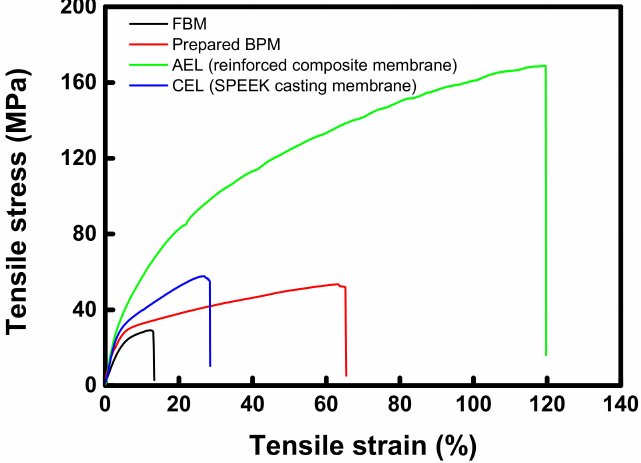
Figure 9. Tensile stress–strain curves of FBM and fabricated membranes (AEM, CEM, and